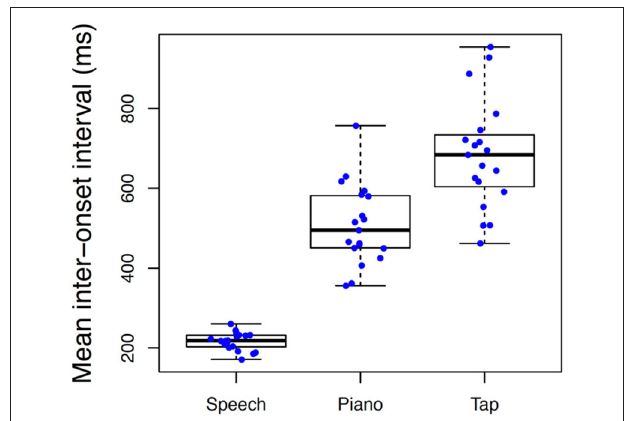
FIGURE 4 | Boxplot illustrating differences in spontaneous rate across conditions. Individual boxplots represent the inter-quartile range (rectangle), median (dark horizontal line) and extreme scores (whiskers). Individual participant means are superimposed on box plots with random jitter along the x-axis to avoid occlusion of data